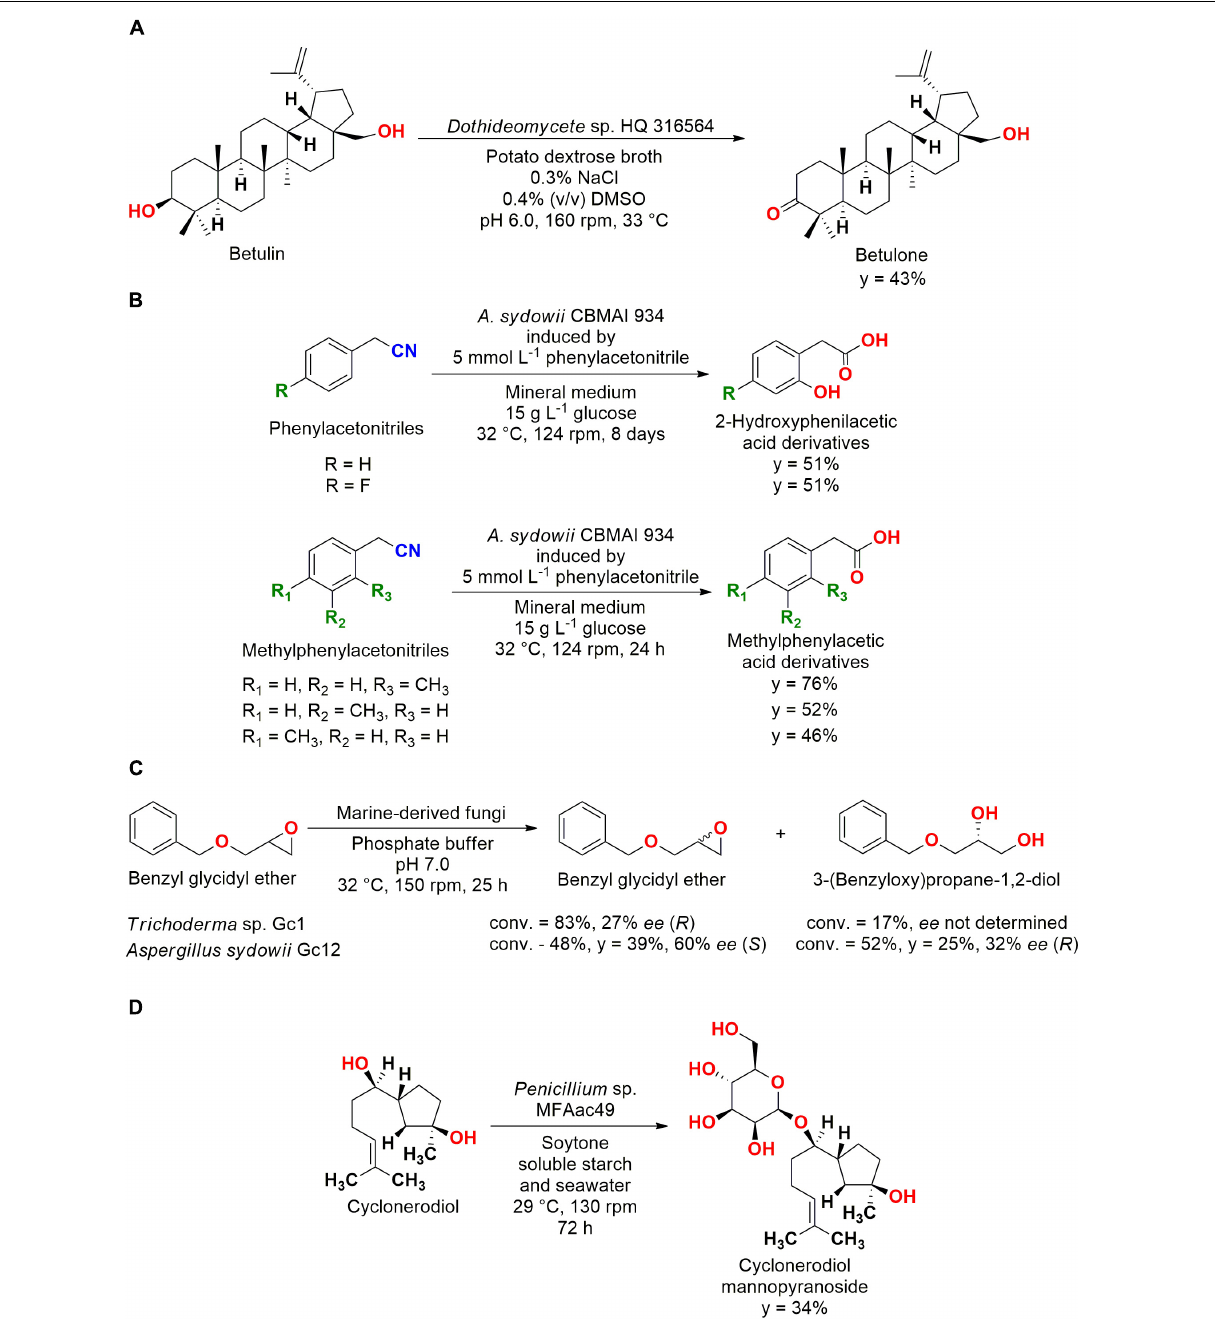
FIGURE 6 | (A) Oxidation of betulin to betulone by Dothideomycete sp. HQ 316564 (Liu et al., 2013). (B) Hydrolysis of phenylacetonitrile derivatives to 2-hydroxyphenylacetic acids by A. sydowii CBMAI 934 (De Oliveira et al., 2013, 2014). (C) Kinetic resolution of benzyl glycidyl ether by A. sydowii Gc12 and Trichoderma sp. Gc1 (Martins et al., 2011). (D) Conjugation and biotransformation of cyclonerodiol by Penicillium sp. MFAac49 (Li et al.,